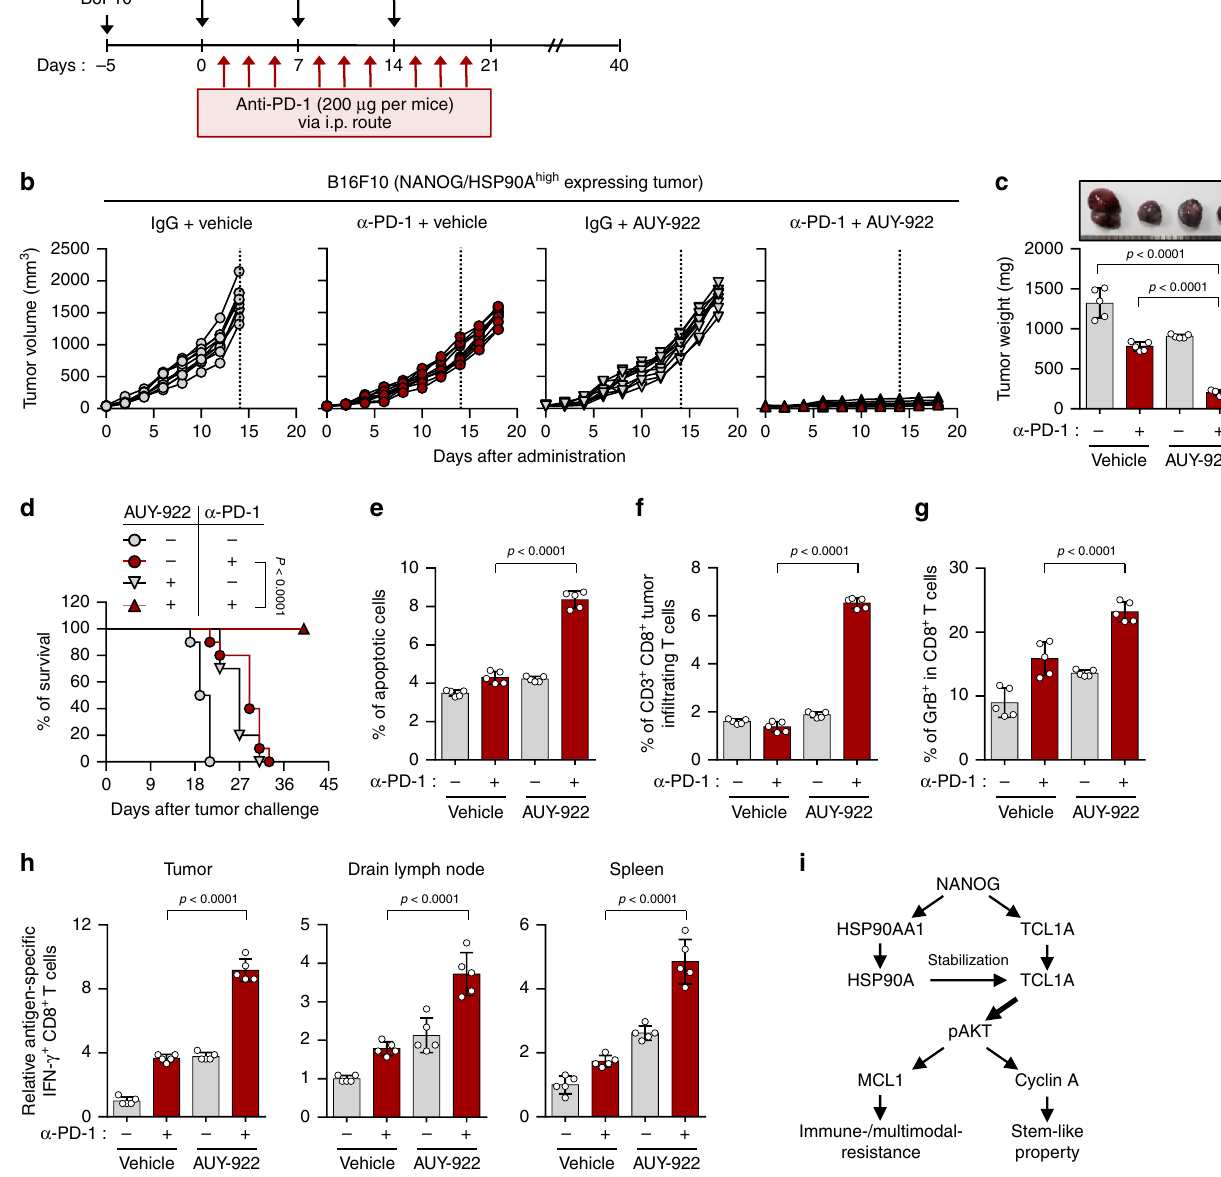
Fig. 8 HSP90A inhibition renders the tumor susceptible to anti-PD-1-mediated anti-tumor immunity. a Schematic of the therapy regimen in mice implanted with B16F10 cells. b – h Tumor-bearing mice administered vehicle or AUY-922, with or without treatment of PD-1 antibody. b Tumor growth and c tumor mass in mice at 19 days after challenge. d Survival of mice inoculated with B16F10 cells treated with the indicated reagents. e The frequency of apoptotic cells in the tumors of vehicle-treated or AUY-922-treated mice, with or without anti-PD-1 treatment. f Flow cytometry pro fi les of tumor- in fl itrating CD3 + and CD8 + T cells. g The ratio of Granzyme B + to tumor-in fl itrating CD3 + CD8 + T cells. h Quanti fi cation of antigen-speci fi c CTLs in tumor (left), drain lymph node (middle), or spleen (right) derived from the tumor-bearing mice. i Schematic interpretation of the molecular mechanism by which NANOG – HSP90A – TCL1A axis promotes multi-modal-resistance and stem-like property of immune-refractory tumor cells. Numbers below blots indicate the expression as measured by fold change. For in vivo experiments, 10 mice from each group were used. The p -value by one-way ANOVA c and e – h or Log-rank (Mantel – Cox) test d is indicated. Data represent the mean ± SD. Source data are provided as a Source Data fi